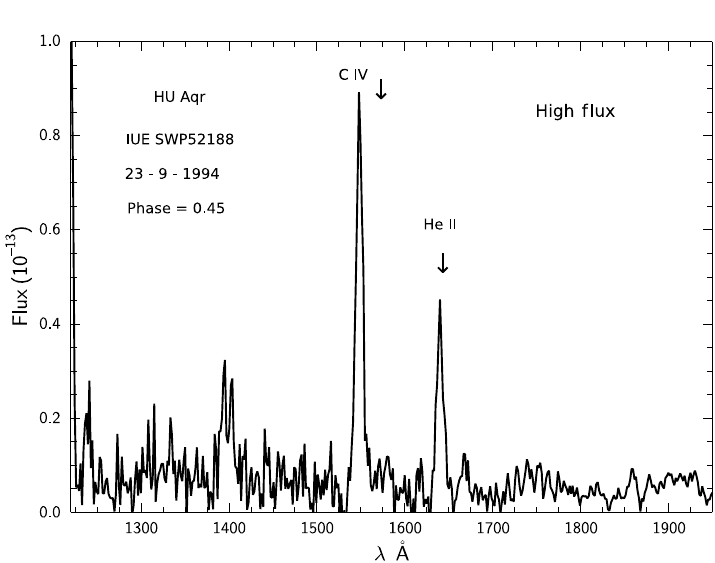
Fig. 1. IUE spectrum of HU Aqr with high (cid:13)ux at phase 0.45. The (cid:13)ux is plotted in units of erg cm (cid:0) 2 s (cid:0) 1 (cid:23)A (cid:0) 1 .